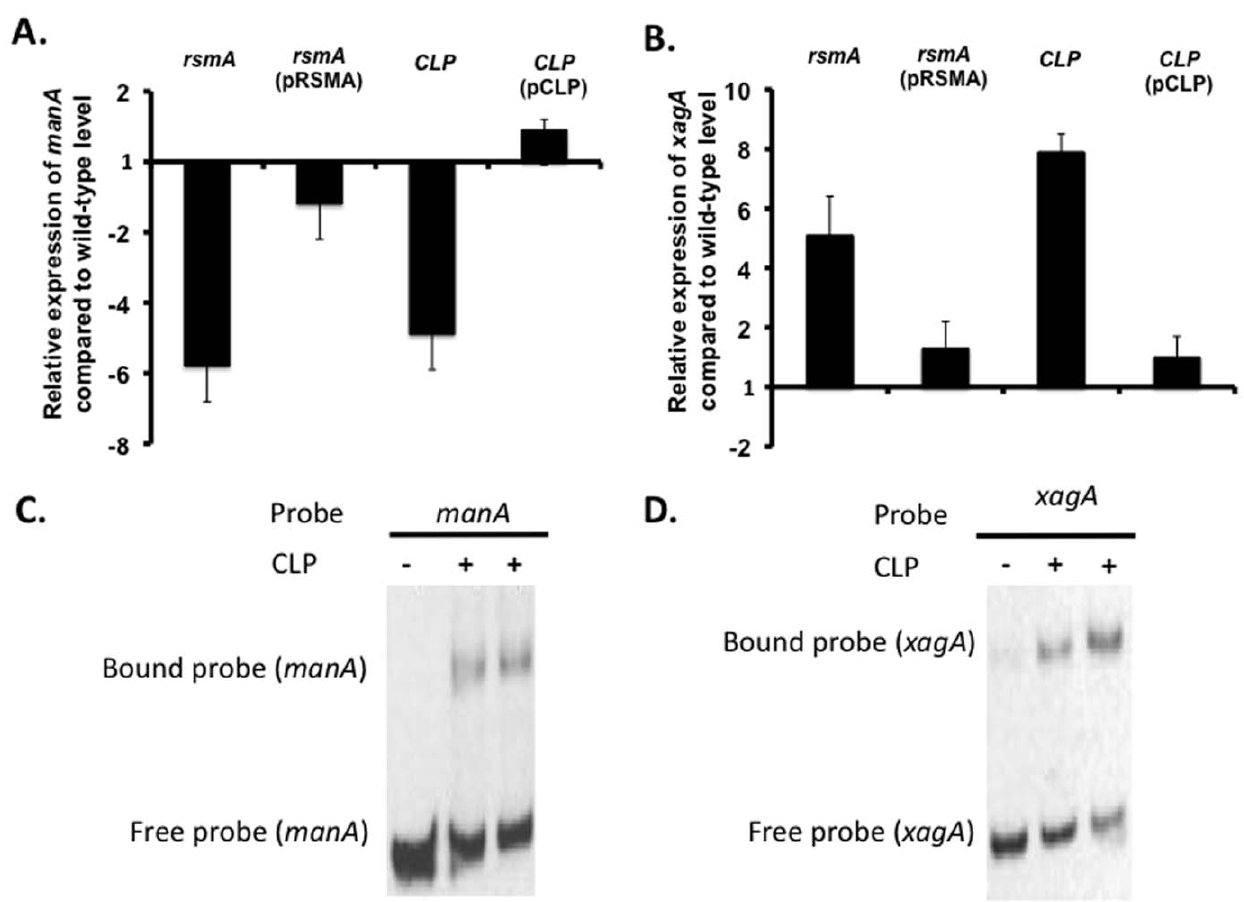
Figure 7. Clp divergently regulates the expression of manA and xagA but binds to the promoter region of both genes. (A, B) Expression of genes encoding manA and xagA was measured in the wild-type strain (8004), rsmA and clp mutant backgrounds by qRT-PCR as described in the Methods . Bacterial strains were grown to an OD at 600 nm of 0.8 in complex medium before RNA extraction. All qRT-PCR results were normalized using the Ct s obtained for the 16S rRNA amplifications run in the same plate. The relative levels of gene transcripts were determined from standard curves. The results shown are the means and standard deviations of triplicate measurements (C, D) Binding of Clp protein to the manA and xagA promoter region was assessed using EMSA. Each lane contained 1.5 nM DIG-labelled Probe DNA with in addition 20 m M purified GST (lane 1); 20 m M purified GST-tagged Clp (lane 2); 25 m M purified GST-tagged Clp (lane 3).